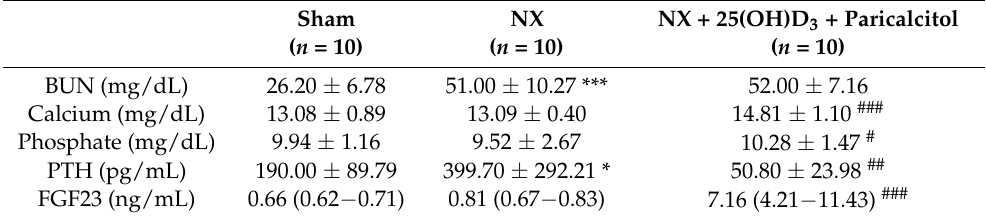
Table 1. Serum biomarkers of bone and mineral metabolism. Values indicate Mean ± SD or Median (interquartile range). * p < 0.05 and *** p < 0.001 vs. Sham; # p < 0.05, ## p < 0.01 and ### p < 0.001 vs. NX